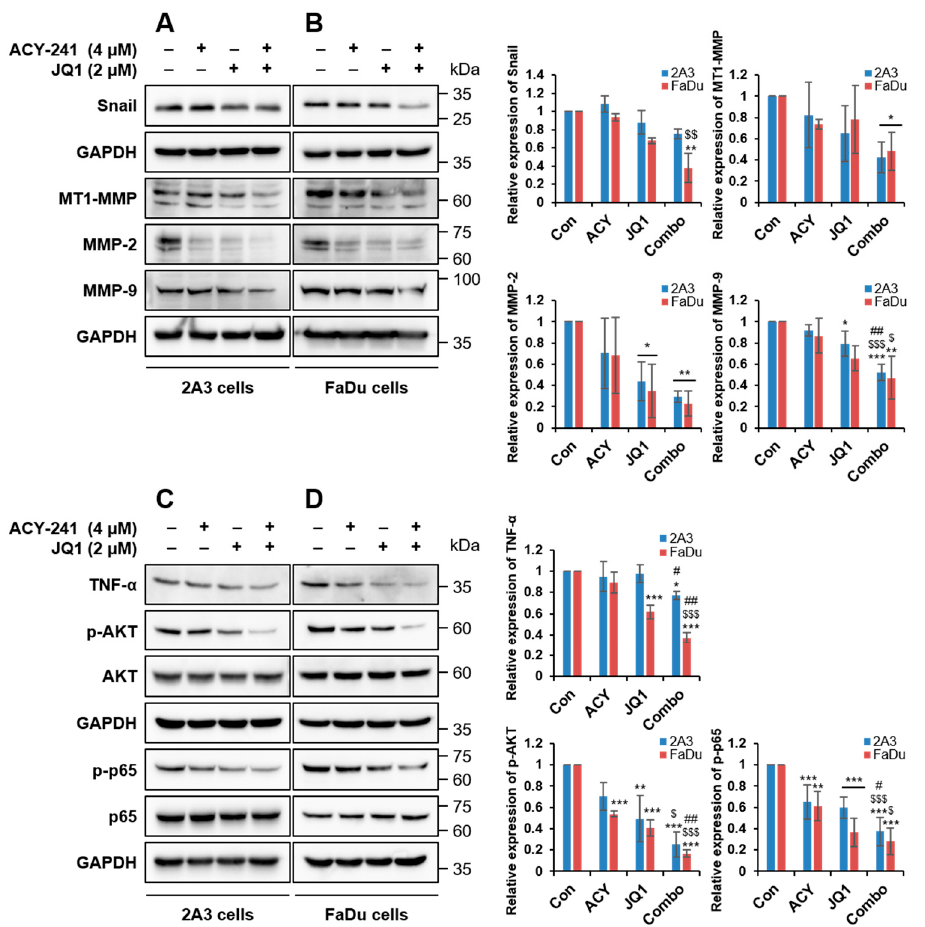
Figure 4. Combination treatment of ACY-241 and JQ1 synergistically downregulates MMP-2 and MMP-9 via inhibition of TNF- α / AKT / -NF- κ B cascade in HNSCC. ( A , B ) Immunoblot analysis of Snail and MMP proteins (MMP-2, MMP-9, MT1-MMP) in 2A3 and FaDu cells. ( C , D ) Immunoblot analysis of EMT signaling factors (TNF- α , AKT, NF- κ B) in 2A3 and FaDu cells. GAPDH was used as a loading control. Protein levels were quantified relative to the loading control. Total protein was extracted after 24 h of ACY-241 (4 µ M) or JQ1 (2 µ M) treatment alone or in combination. Values represent mean ± SD ( n = 3). * p < 0.05, ** p < 0.01, or *** p < 0.001 vs. DMSO control, $ p < 0.05, $$ p < 0.01, or $$$ p < 0.001 vs. ACY-241-treated group, # p < 0.05 or ## p < 0.01 vs. JQ1-treated